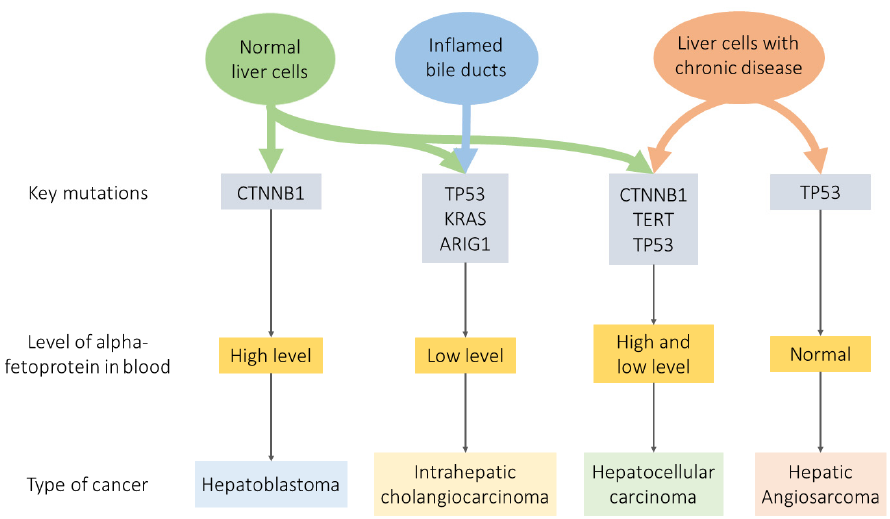
Figure 3. Significant liver cancer